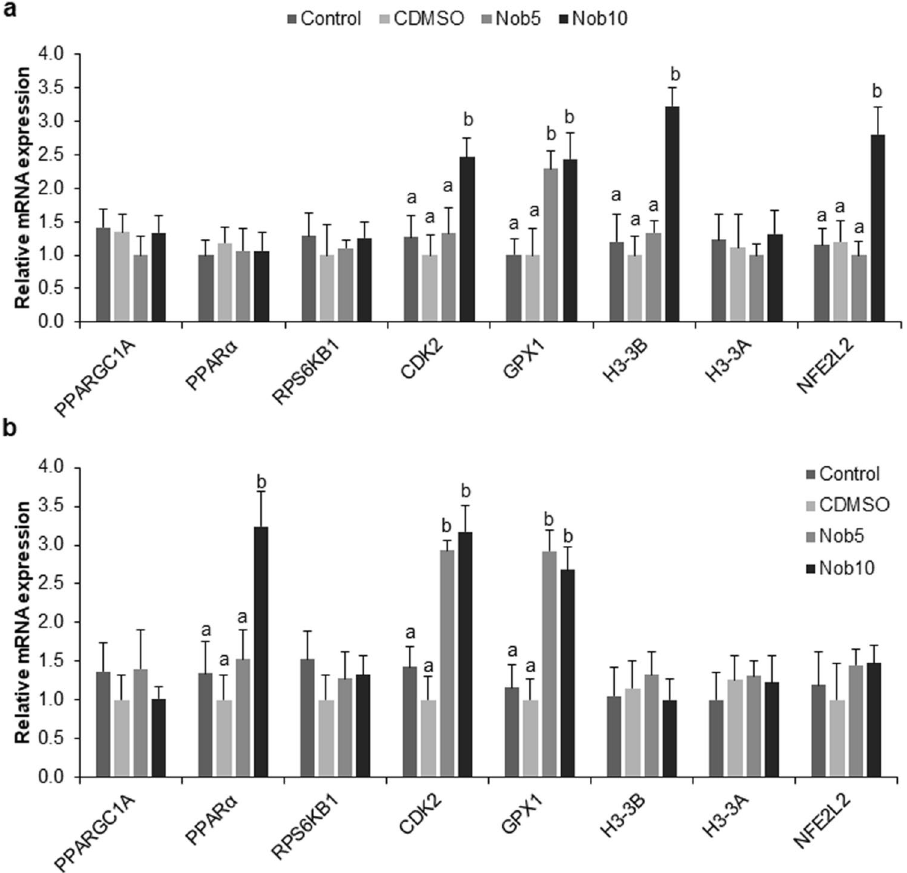
Figure 5. Relative mRNA transcript abundance of embryo development-related genes in in vitro produced embryos cultured during 54–96 hpi (MJ EGA : 8-to 16-cell stage) with or without nobiletin. ( a ) Relative abundance in16-cell stage embryos cultured in SOF + 5% FCS (Control), supplemented or not with 5 (Nob5) or 10 µM (Nob10) nobiletin or with 0.03% dimethyl sulfoxide (C DMSO ) during MN EGA phase. ( b ) Relative abundance in blastocysts from Control, Nob5, Nob10, and C DMSO experimental groups from MJ EGA phase. The relative abundance of the transcripts was normalized to H2AFZ and ACTB as housekeeping genes. Data are the mean ± s.e.m. Different letters indicate significant difference ( P < 0.05) between